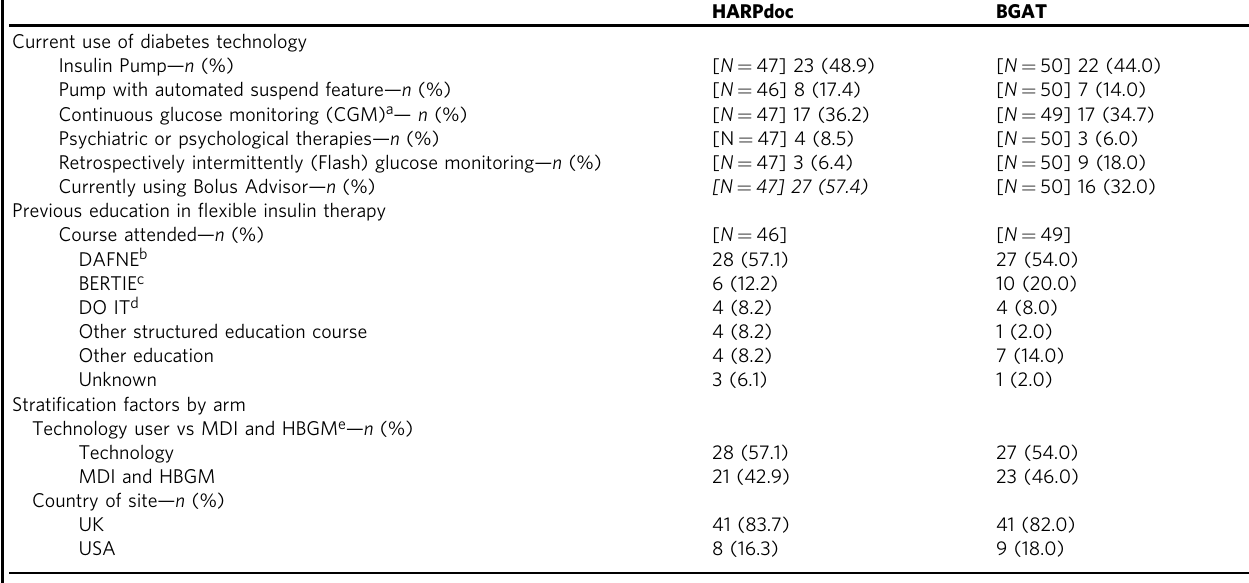
Table 2 Experience at baseline of interventions in the therapeutic pathway for people with type 1 diabetes and problematic hypoglycaemia (education and technology) and strati fi cation of randomisation in the HARPdoc RCT. N = numbers of participants with